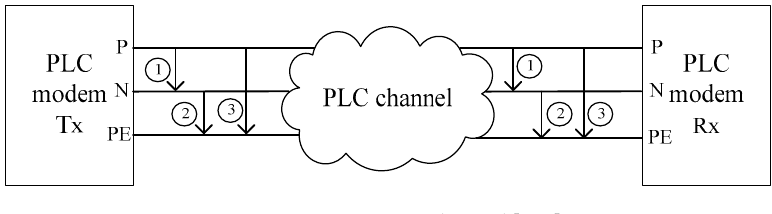
Figure 9. MIMO PLC channel [116].